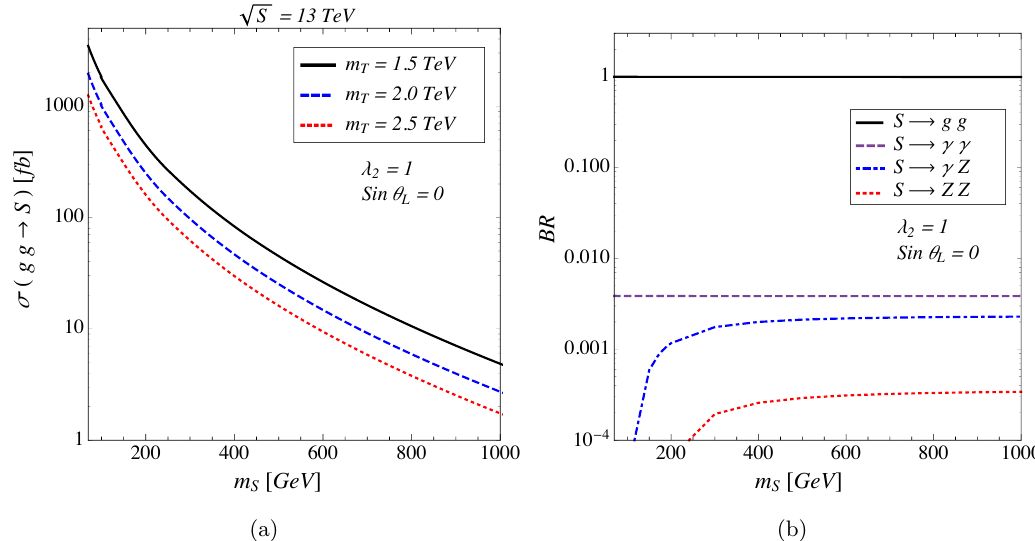
Figure 13 . (a) The single S production cross sections via gluon fusion at N 3 LO accuracy in QCD at p S = 13 TeV for (black solid) m T = 1 : 5 TeV, (blue dash) m T = 2 TeV, and (red dot) m T = 2 : 5 TeV. (b) The branching ratios of S decaying into (black solid) gg , (violet dash) (cid:13)(cid:13) , (blue dash-dot) (cid:13)Z , and (red dot) ZZ (cid:12)nal states. All plots are made in with zero top partner-top